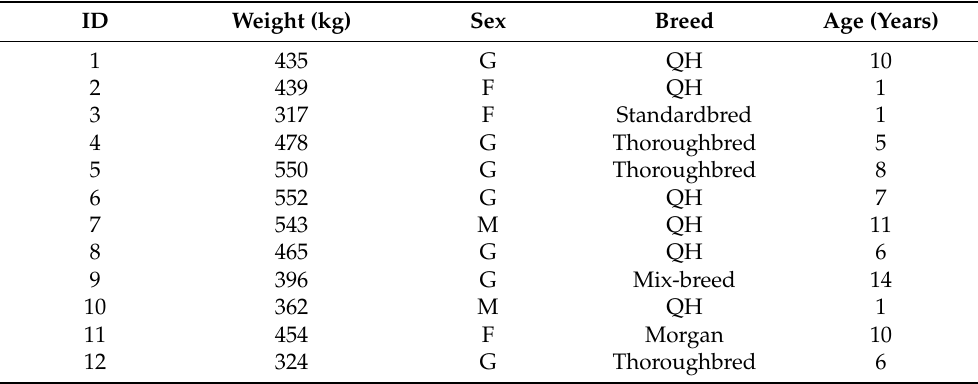
Table 1. The sex, breeds, age, and weight of the 12 horses enrolled in this